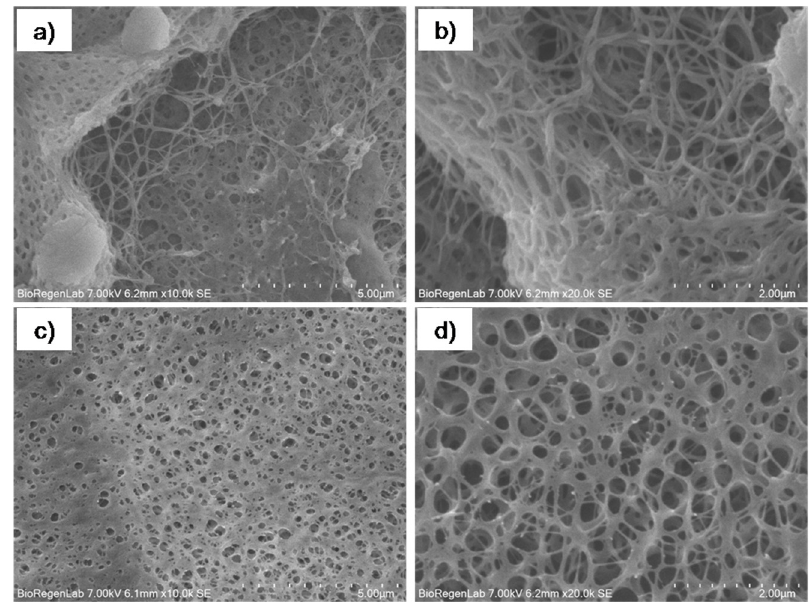
Figure 3. SEM images ( A , B ) of the exposed side and ( C , D ) of the side in contact with the mandrel 10,000× and 20,000×.